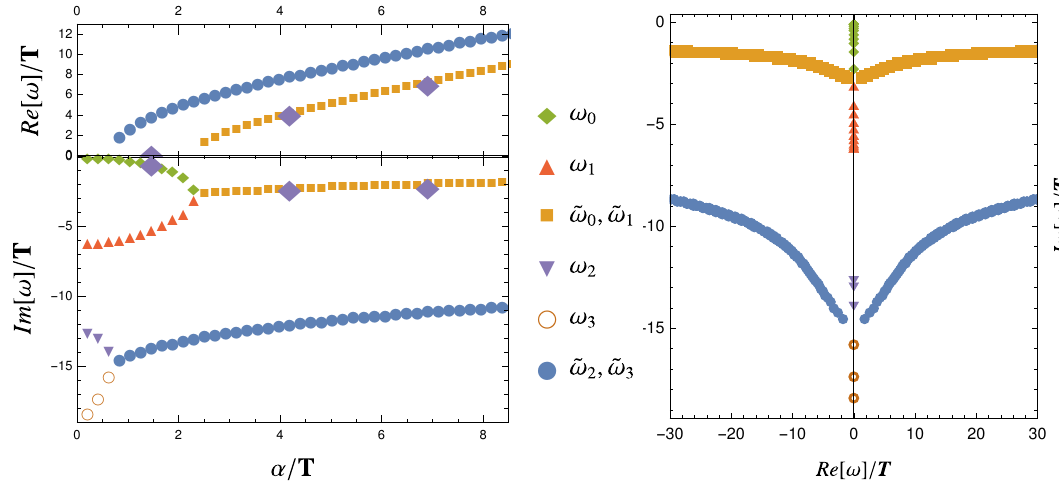
Figure 4 . Cylindrical quasinormal modes of the Schwarzschild black hole (2.1). Left panel: real and imaginary parts as functions of the radial scale parameter (cid:11) , (4.1). Right panel: QNM positions on the complex ! plane for all radial scale parameters (cid:11) 2 (0 ; 32) T overlaid. The evolution of 4 modes is visible, going from purely decaying Re ( ! i ) = 0 to oscillatory pairs Re (~ ! i ) 6 = 0. The mode ! 0 can be identi(cid:12)ed with the hydrodynamic charge di(cid:11)usion, while the others are non-hydrodynamical. Purple diamonds on the left panel show the parameters of the modes extracted from late time analysis, see table